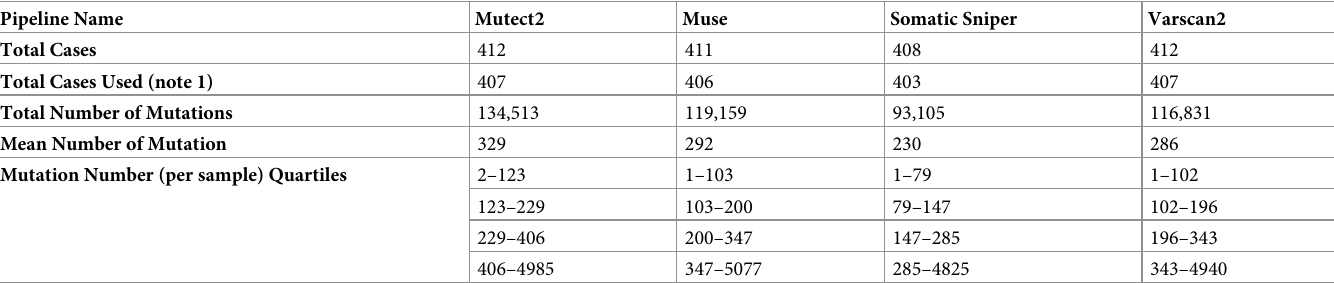
Table 2. Statistical profiles of mutation calling